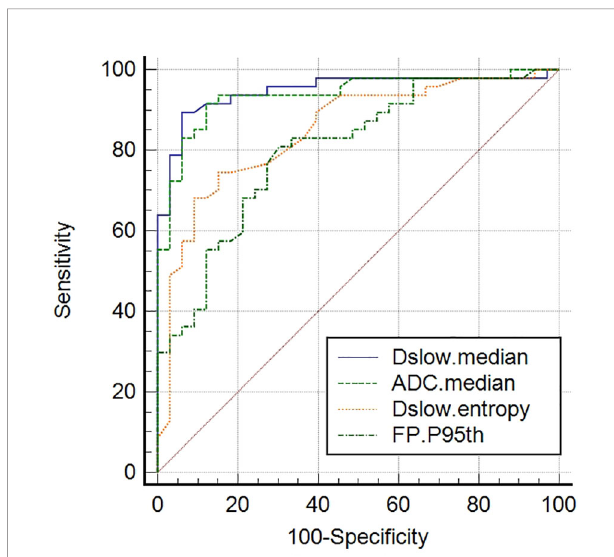
FIGURE 4 | Receiver operating characteristic (ROC) curves of screened independent in fl uencing factors that could distinguish poorly differentiated from well/moderately differentiated GCs. ADC median , Dslow median , and Dslow entropy show good diagnostic performance, with AUCs of 0.937, 0.948, and 0.850, respectively. Comparisons among the four metrics determined that these values were signi fi cantly different (P <0.05), although no differences (P >0.05) were detected when paired comparisons among the ADC median , Dslow median , and Dslow entropy values were performed.